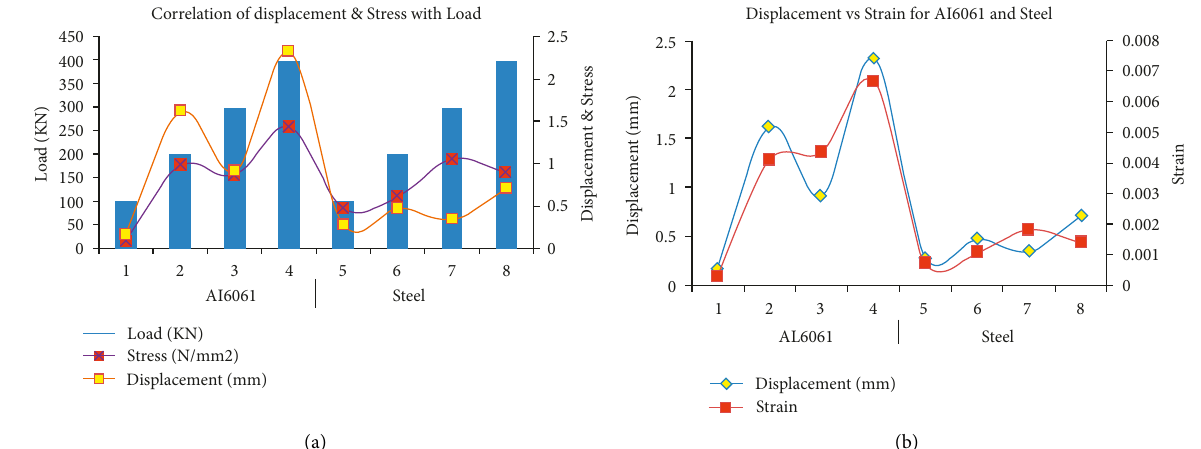
Figure 6: Interrelation of displacement, stress, and strain for the various loads.